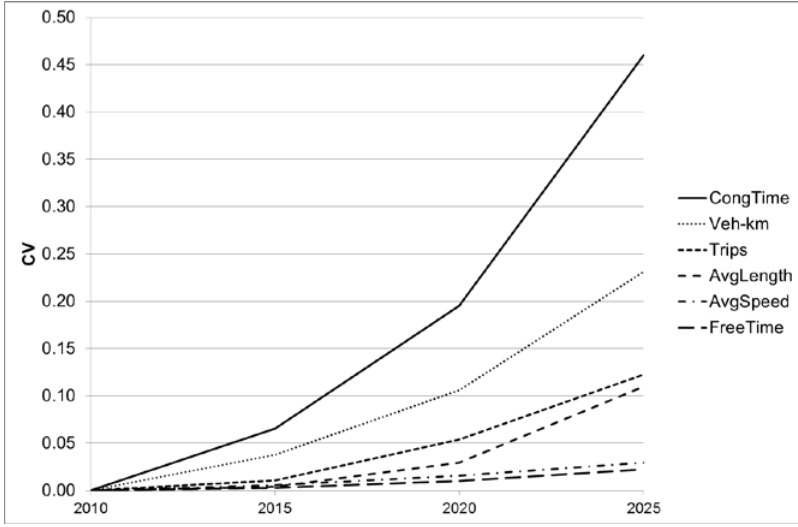
Figure 4. CV propagation over